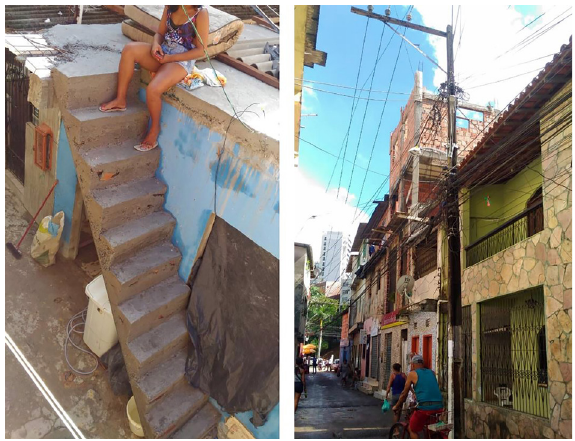
Fig. 1. Risky situations